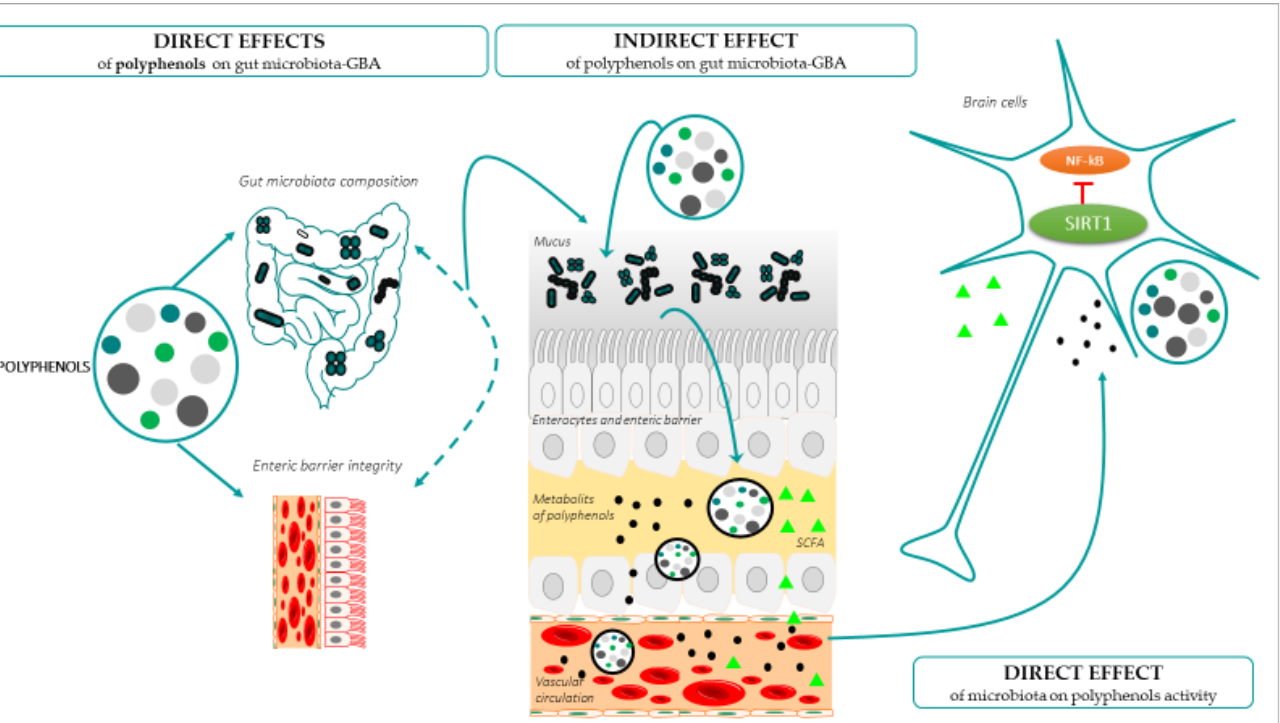
Figure 3. Direct and indirect effects of polyphenols on gut microbiome and how these changes di- rectly affect brain